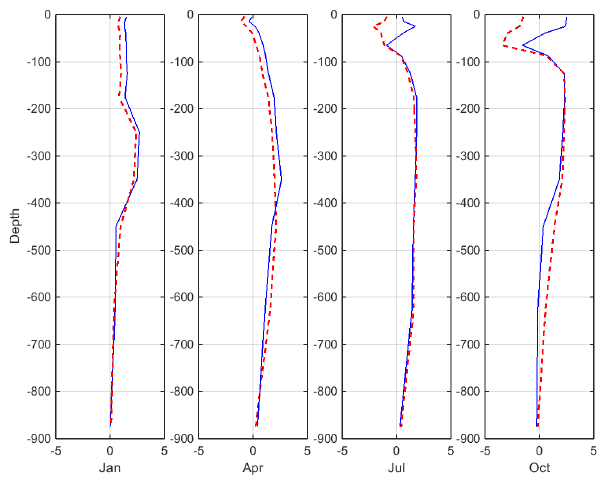
Figure 11. Chlorophyll profiles from the control and reference run using the higher-resolution model in June (a) in the Norwegian Sea box as well the difference between observations and model in other months (b) – solid lines are the revised simulation and dashed lines the control run. All observations in the Norwegian Sea box between 1998 and 2001 have been